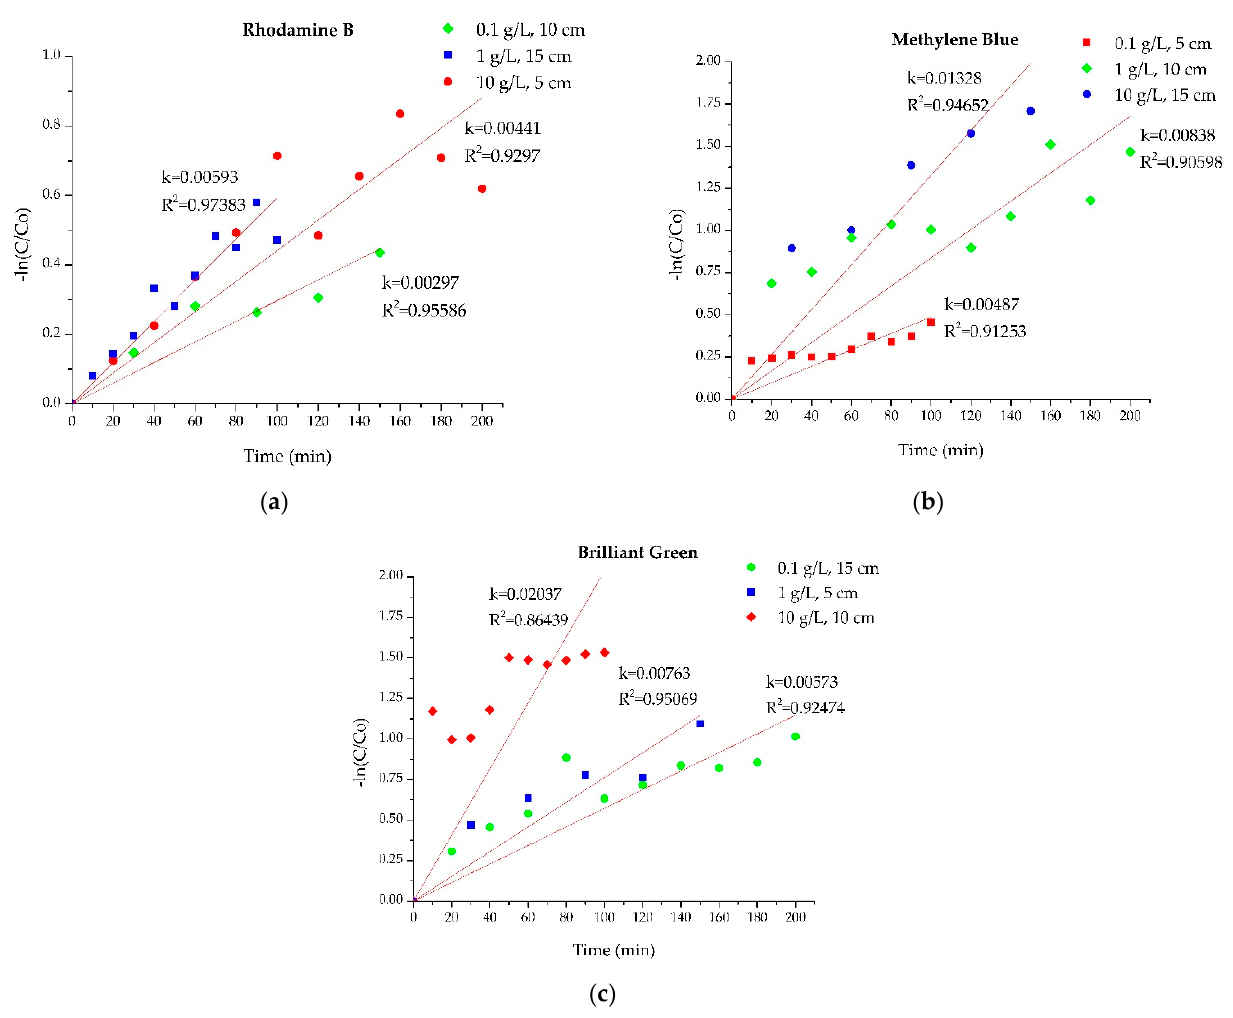
Table 3. Percentage of effect of each factor on the final degradation according to Taguchi method. Factor